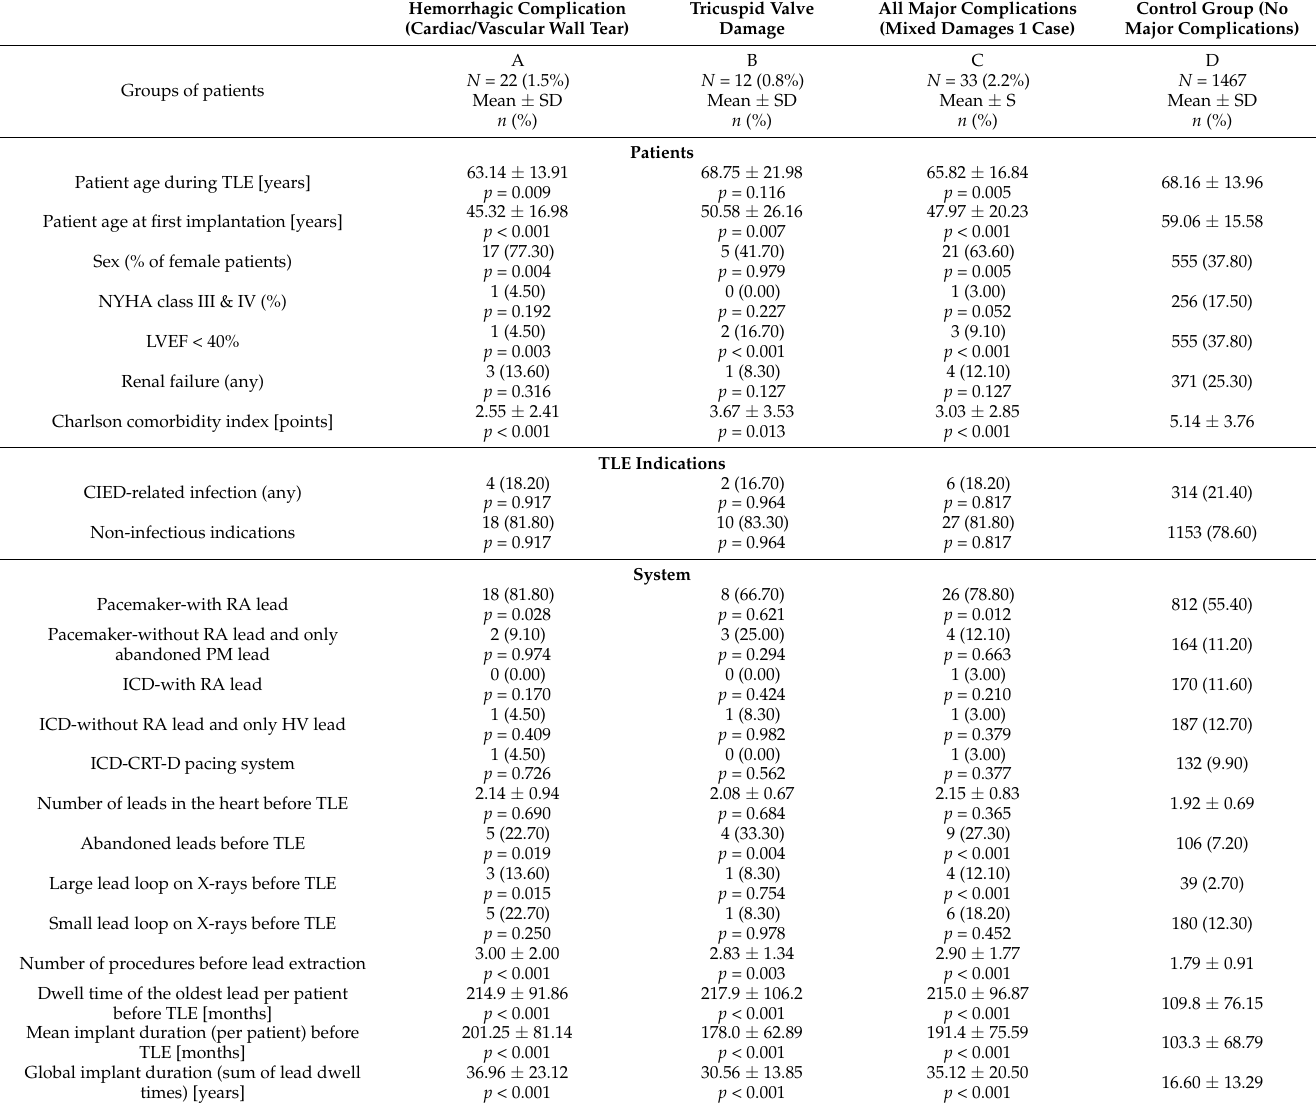
Table 1. Patient/system/history of pacing.